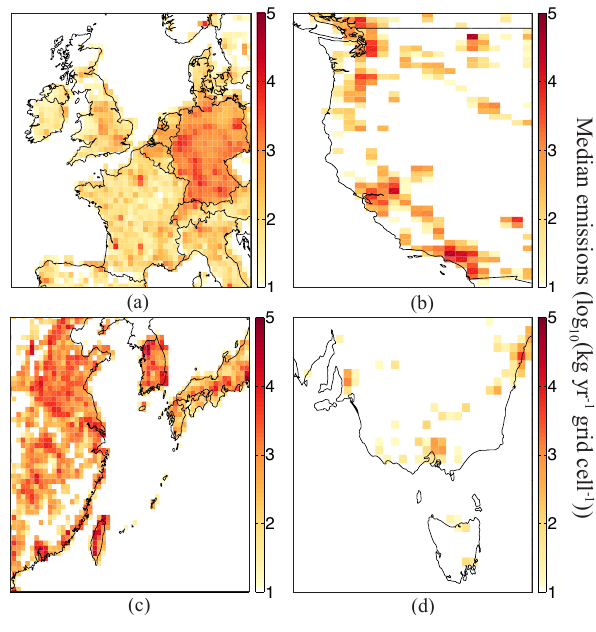
Fig. 2. Median 2012 SF 6 emissions for regions around (a) Mace Head, Ireland; (b) Trinidad Head, USA; (c) Gosan, South Ko- rea; and (d) Cape Grim, Australia. Derived emissions were re- distributed from the aggregated regions solved for in the inversion by assuming the distribution of EDGAR emissions.